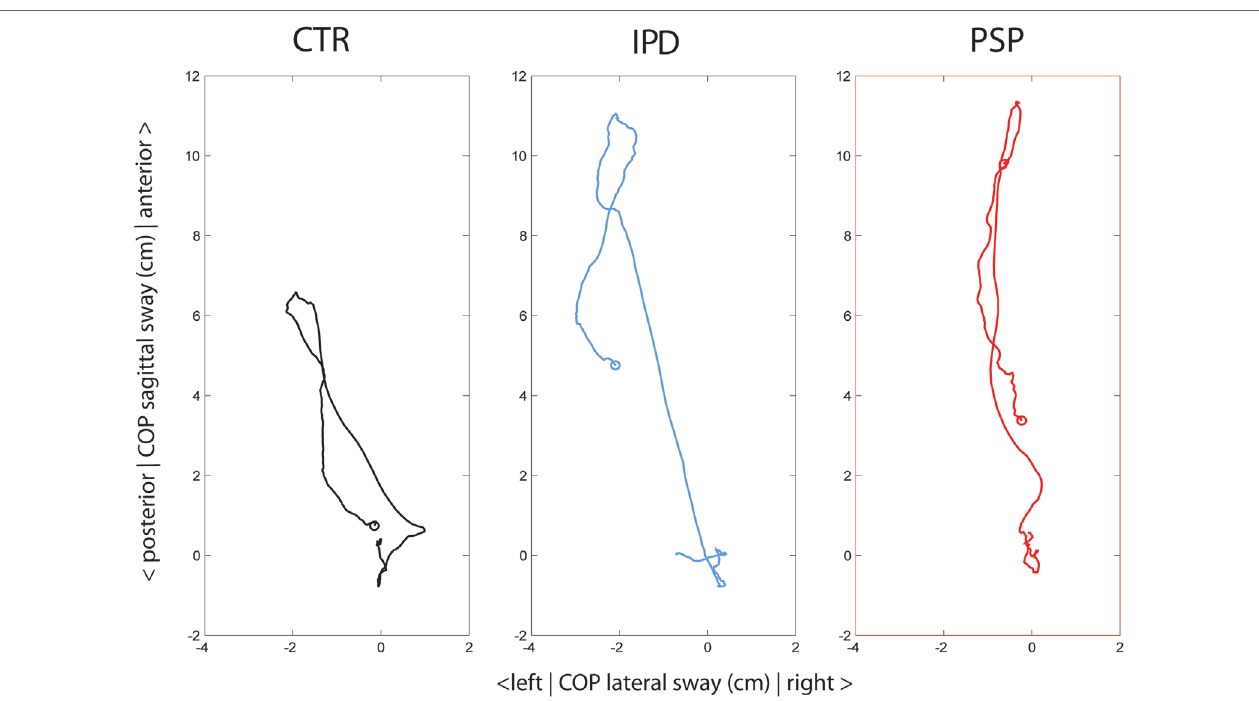
FigUre 2 | Subjects’ averaged center of foot pressure (COP) depicted from an on-top viewpoint throughout the weight-lifting cycle with the right arm, from − 1 s before lift to + 5 s after lifting. Groups are color-coded control subjects (CTR, black), idiopathic Parkinson’s disease (IPD) (blue) and progressive supranuclear palsy (PSP) (red). The circle in each graph depicts the final position of COP at + 5 s, at which the weight was still extended 90°